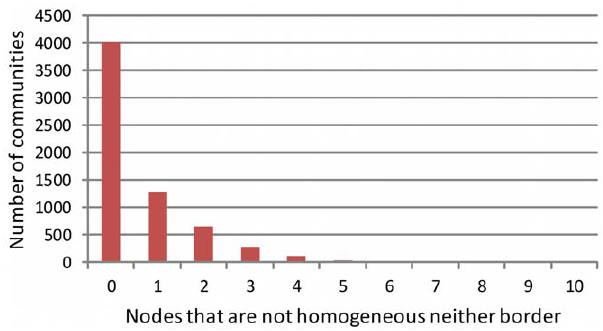
Figure 10. Number of communities identified by the Girvan- Newman algorithm which have none or more nodes that are not homogeneous neither border.